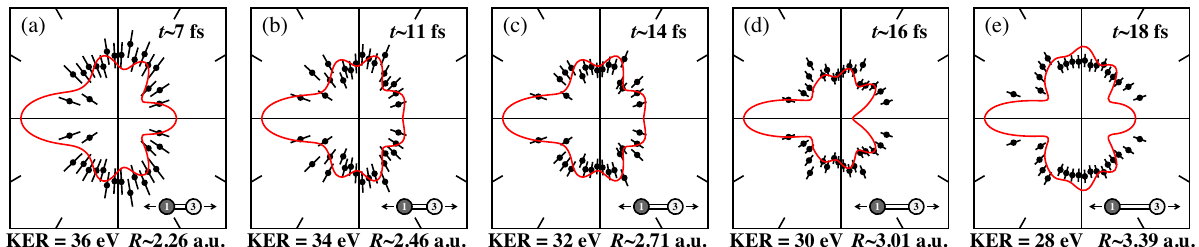
FIG. 6. Polarization-averaged molecular-frame angular distributions of the second photoelectron (emitted during the O þ = O þ Coulomb explosion) for several KERs. The theoretical predictions shown in Fig. 3 are overlayed as red lines (see text for details). The internuclear distances R and the absorption times t of the second photon have been obtained using a simple Coulomb explosion model (see Appendix B). The ion, which is triply charged in the final state, is located on the